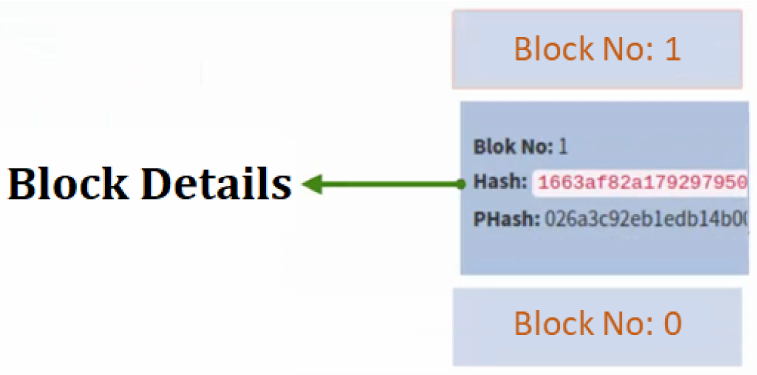
Figure 12. An example of block structure in the proposed blockchain-based system.